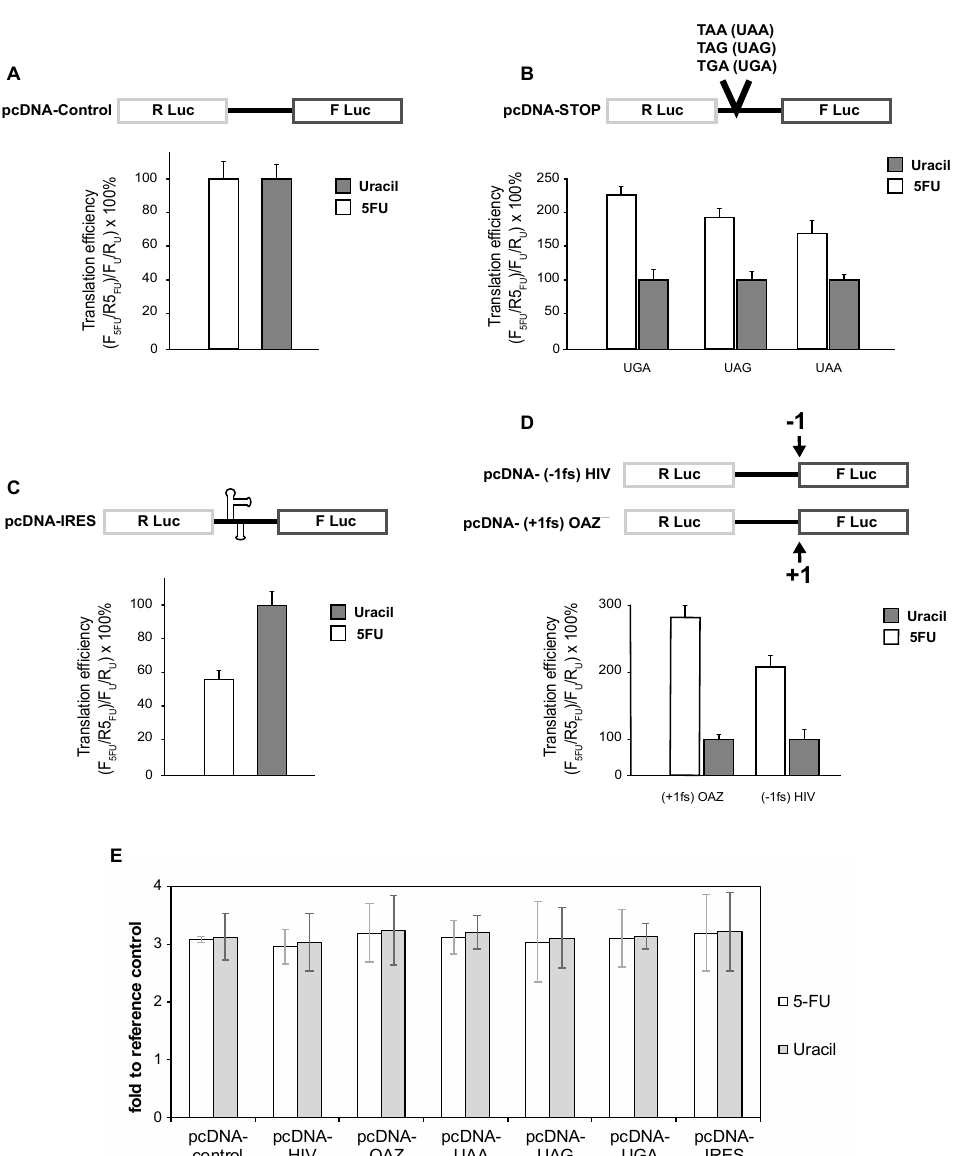
Figure 1. The efficiency of translational recoding is altered by 5-fluorouracil (5-FU) treatment. SW-480 cells harboring the indicated luciferase reporter plasmids were treated with 10 µ M 5-FU or 10 µ M uracil for 24 h before determining luminescence ( A – D ). qRT-PCR analysis of reporter mRNA indicates that 5-FU treatment does not affect reporter mRNA levels ( E ). HIV: human immunodeficiency virus;